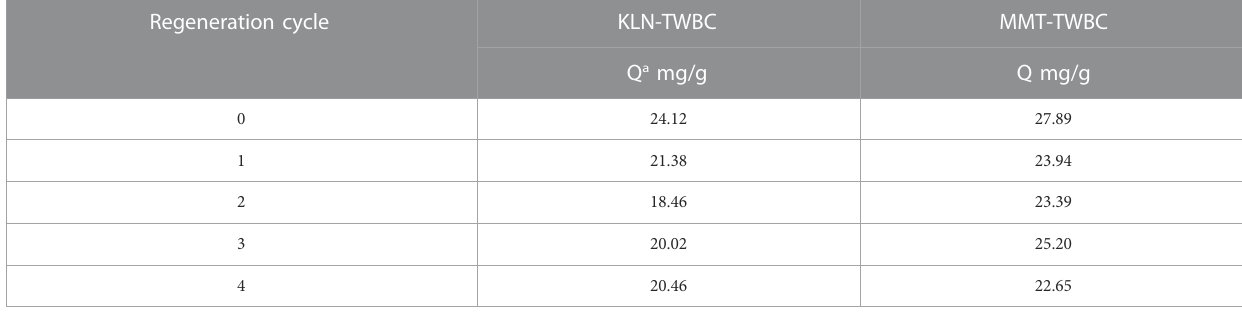
TABLE 3 Regeneration and cycle performance of KLN-TWBC and MMT-TWBC adsorbent. Regeneration